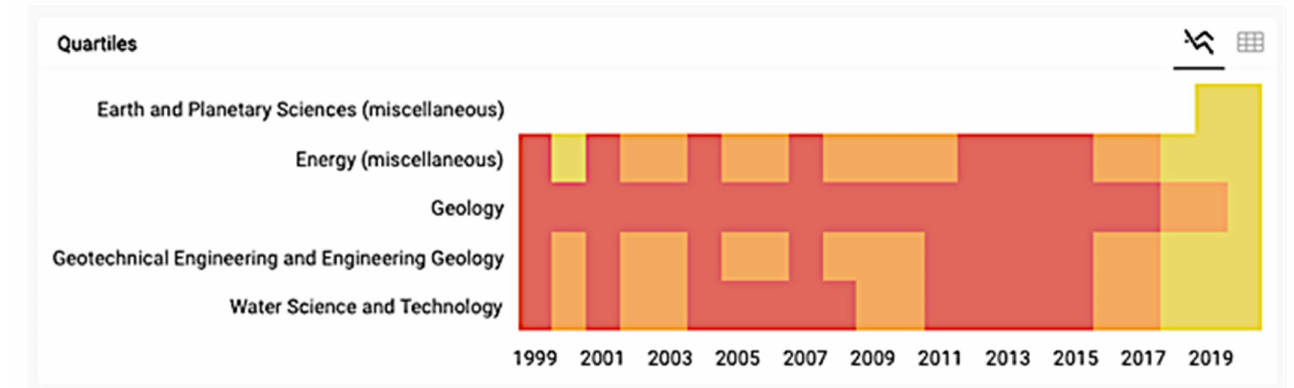
Figure 4. The journal quartiles in Scimago/Scopus based on SJR in five associated categories (colour legend indicates quartiles/Q as follows: Q2 yellow, Q3 orange, Q4 red). In the Scimago representa- tions, the Q1 is marked green. The similar ranking in Scopus is done by Citescore value but it is not part of the Scimago team annual